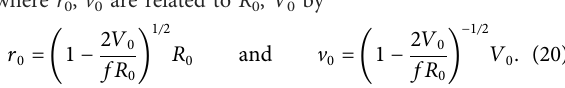
FIGURE 6 AnillustrationofthetransformationrelationsEq.18forthespecialcaseofafamilyofRankinevortices,asde fi nedinEqs.19,20,with R 0 =300 km fR (cid:2) 7 . 5 m s − 1 . Panel (A) shows isolines of the physical azimuthal wind v in the ( r , v and f =5×10 – 5 s − 1 , so that 1 0 2 5 m s − 1 , and panel (B) shows isolines of the transformed azimuthal wind V in the ( R , v 0 )-plane with an isoline interval of 0.5 m s − 1 . In both (A,B) the rangeontheleftordinateis0 ≤ v 0 ≤ 65 m s − 1 .Thiscorrespondstotherange0 ≤ V 0 ≤ 7.403 m s − 1 ,asshownontherightordinateofpanel (B) ,andto the range 0 ≤ ζ 0 / f ≤ 76.10, as shown on the right ordinate of panel (A) , where ζ 0 / f =2 v 0 /( fr 0 ) is the dimensionless core vorticity. Note the striking differenceinthebehaviorof V ( R )and v ( r ).As V ( R 0 )increasesfromrestto7.403 m s − 1 , v ( r 0 )increasesfromrestto65 m s − 1 andtheradiusofmaximum wind decreases from r 0 =300 km to r 0 =34.17